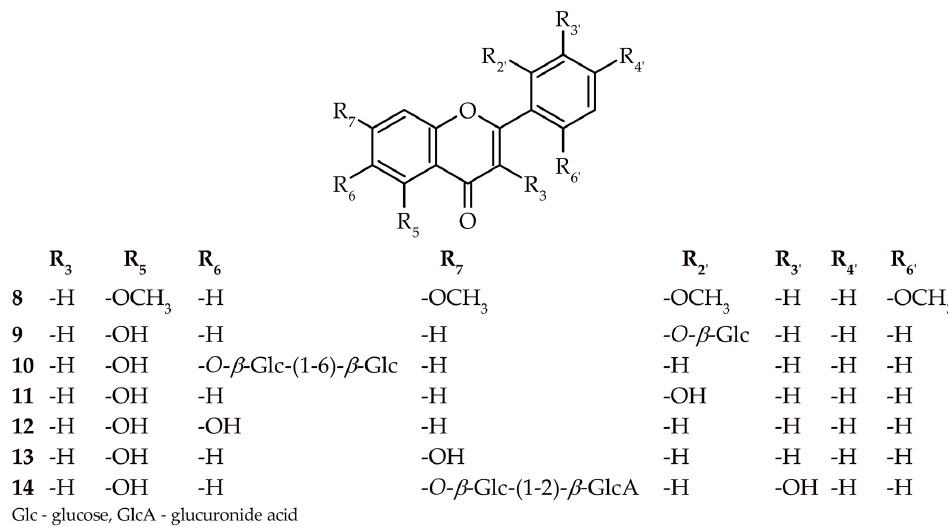
Figure 1. Chemical structures of isolated flavones ( 8–14 ).